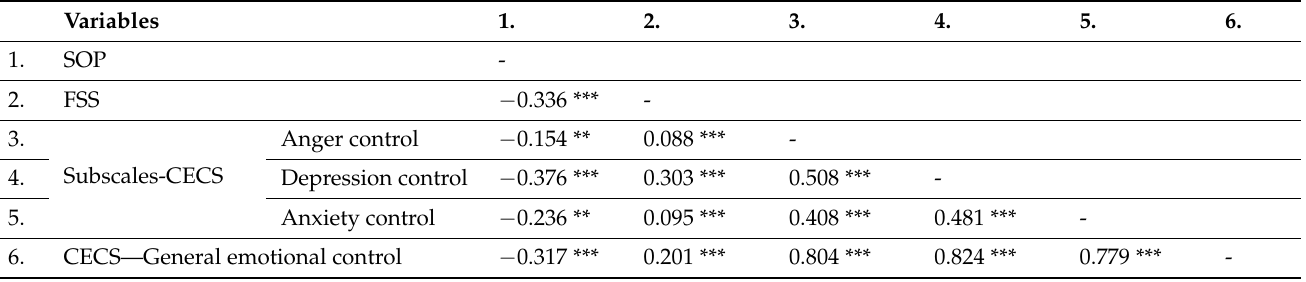
Table 2. A matrix of Pearson correlation (r) coefficients between the variables under analysis.